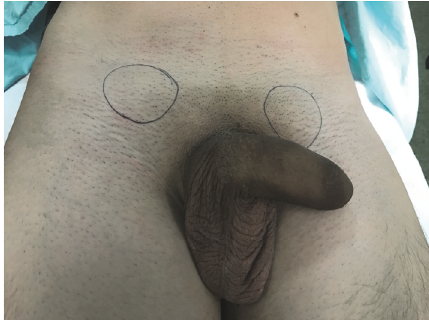
Figure 5: Patient with empty scrotal